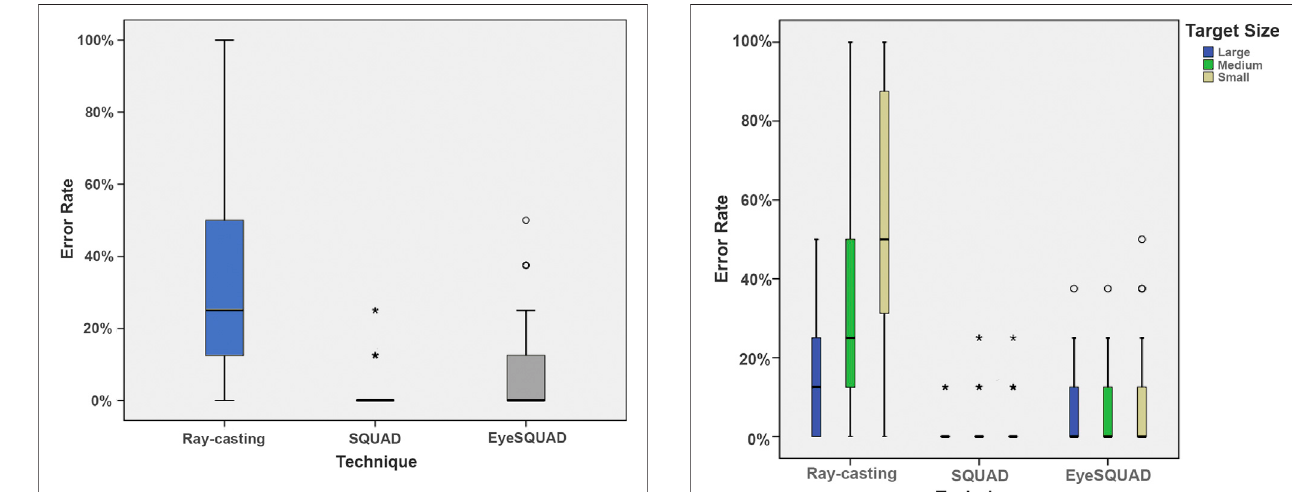
FIGURE 5 | Mean error rate with different techniques.